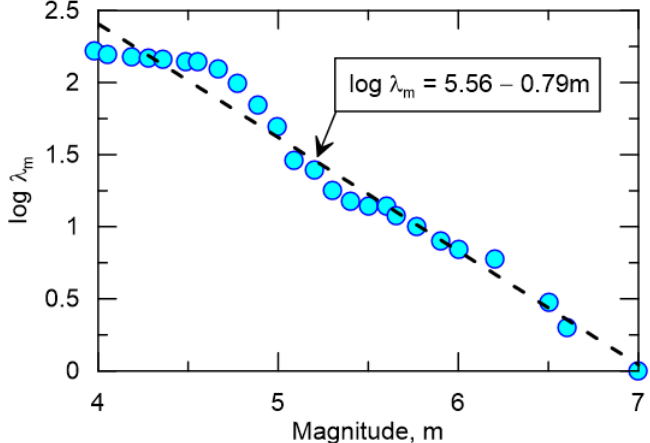
Figure 4. Example Gutenberg–Richter recurrence rate model for seismic zone 1.